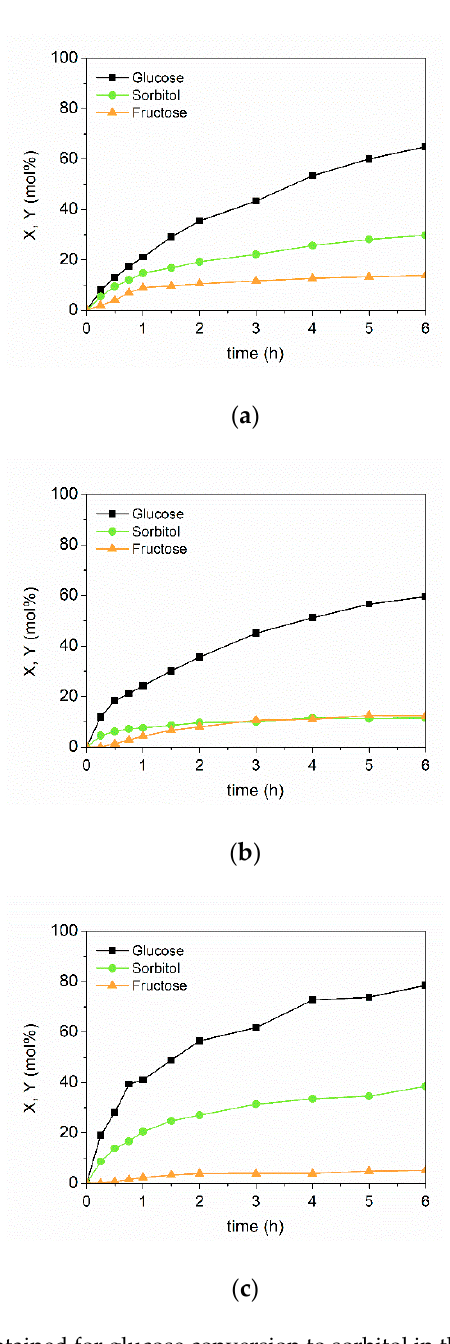
Figure 4. Kinetic profiles obtained for glucose conversion to sorbitol in the presence of Raney nickel type catalysts in ethanol: ( a ) unpromoted Raney nickel, ( b ) Fe–Cr-promoted Raney nickel, and ( c ) Mo-promoted Raney nickel. Reaction conditions: [glucose] = 90 mM, catalyst to substrate weight ratio = 1:4; reaction temperature = 150 °C.